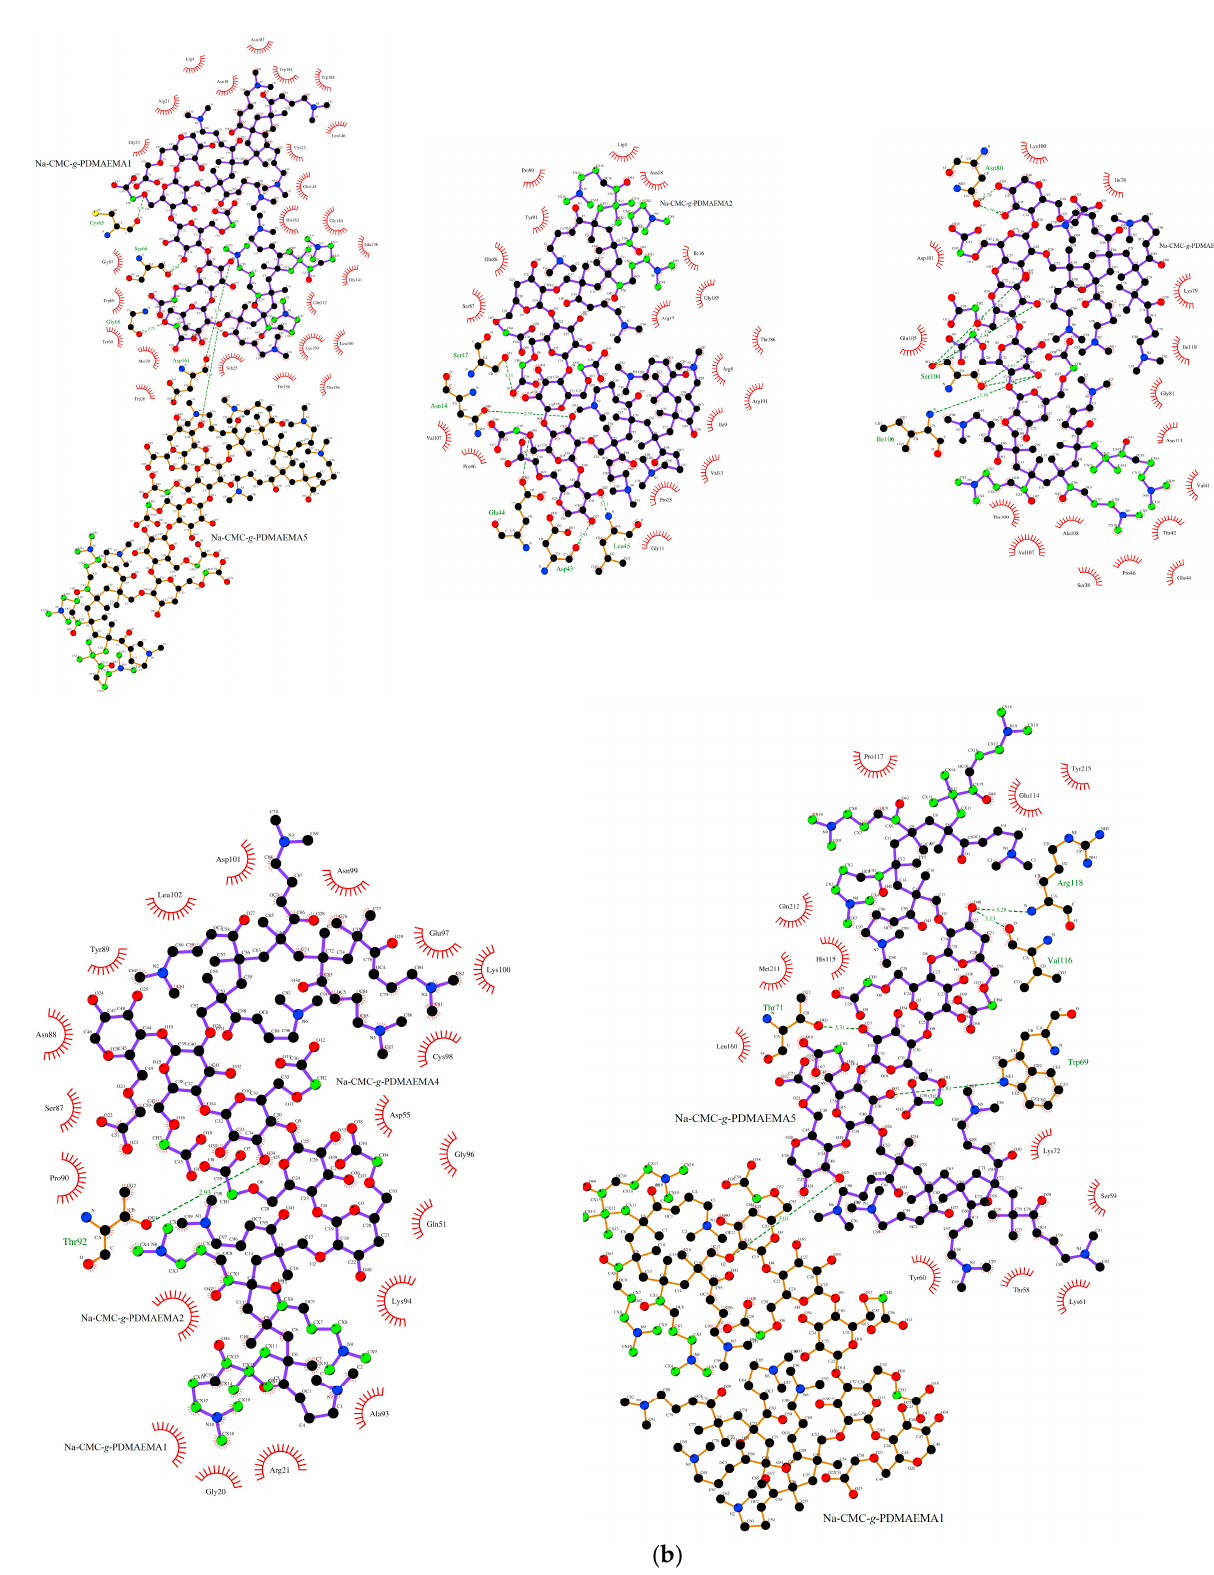
Figure 2. H-bonds (indicated by dashed lines) and interactions between ficin and the molecules of Na-CMC ( a ) and Na-CMC- g -PDMAEMA ( b ).